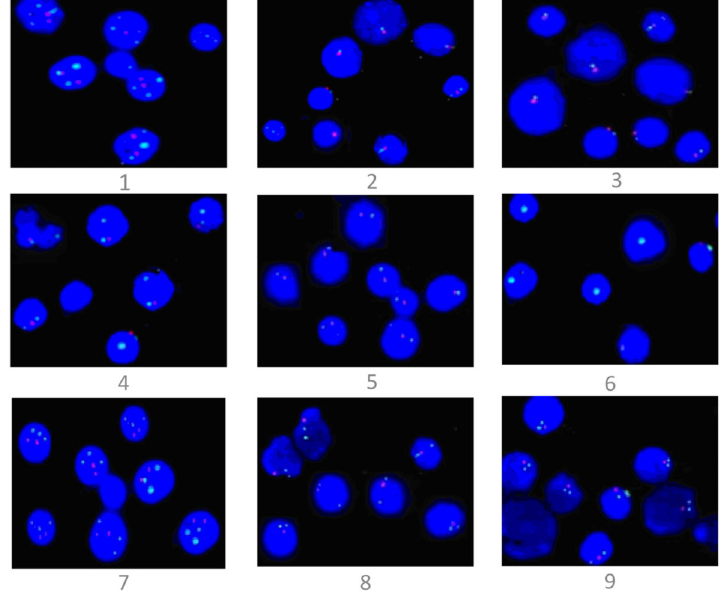
Figure 3. Karyotypic analysis by FISH detection. Various probes were designed for abnormal karyotype detection. 1 and 7 , karyotype of trisomy (++8); 2 , deletion of chromosome 20 (––20); 3 , deletion of chromosome 8 (––8); 4 and 8 , deletion of long arm in chromosome 20 (20q––); 5 , in situ fluorescent signal pattern for the deletion of chromosome 7 (––7); 6 , deletion of Y chromosome (––Y); 9 , deletion of long arm in chromosome 5